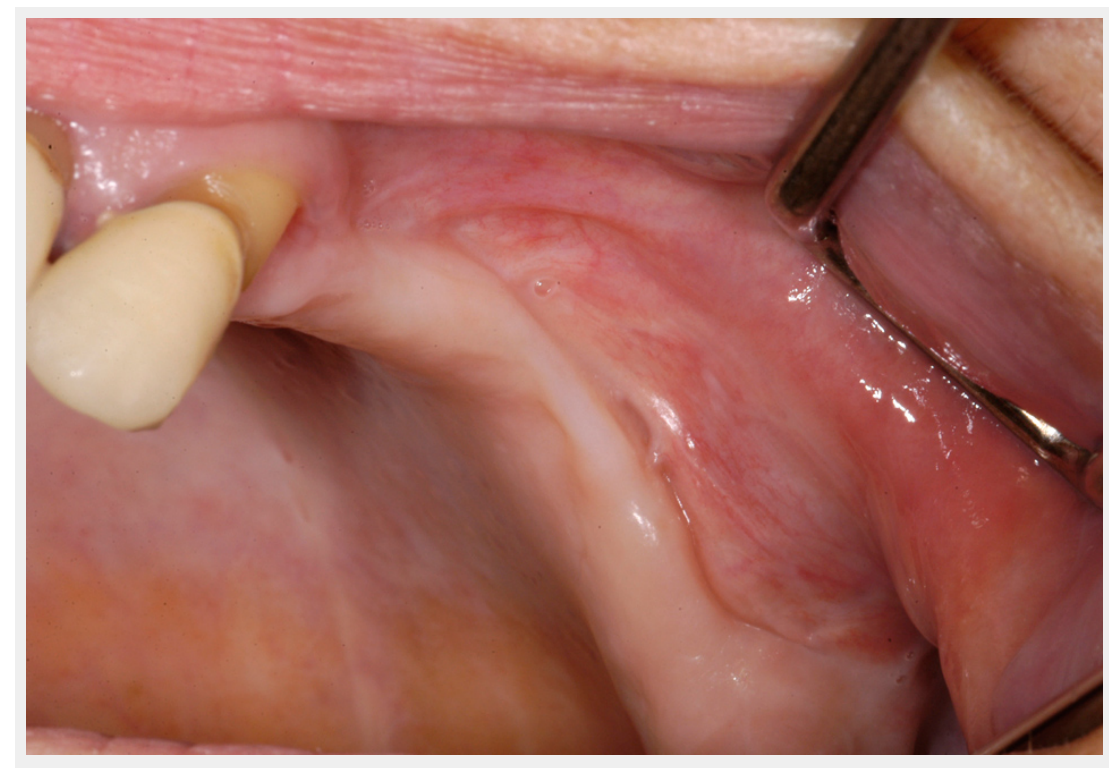
Same patient as figure 2 shows the situation after surgical treatment of BRONJ with complete remission without any remaining dehiscence of the soft